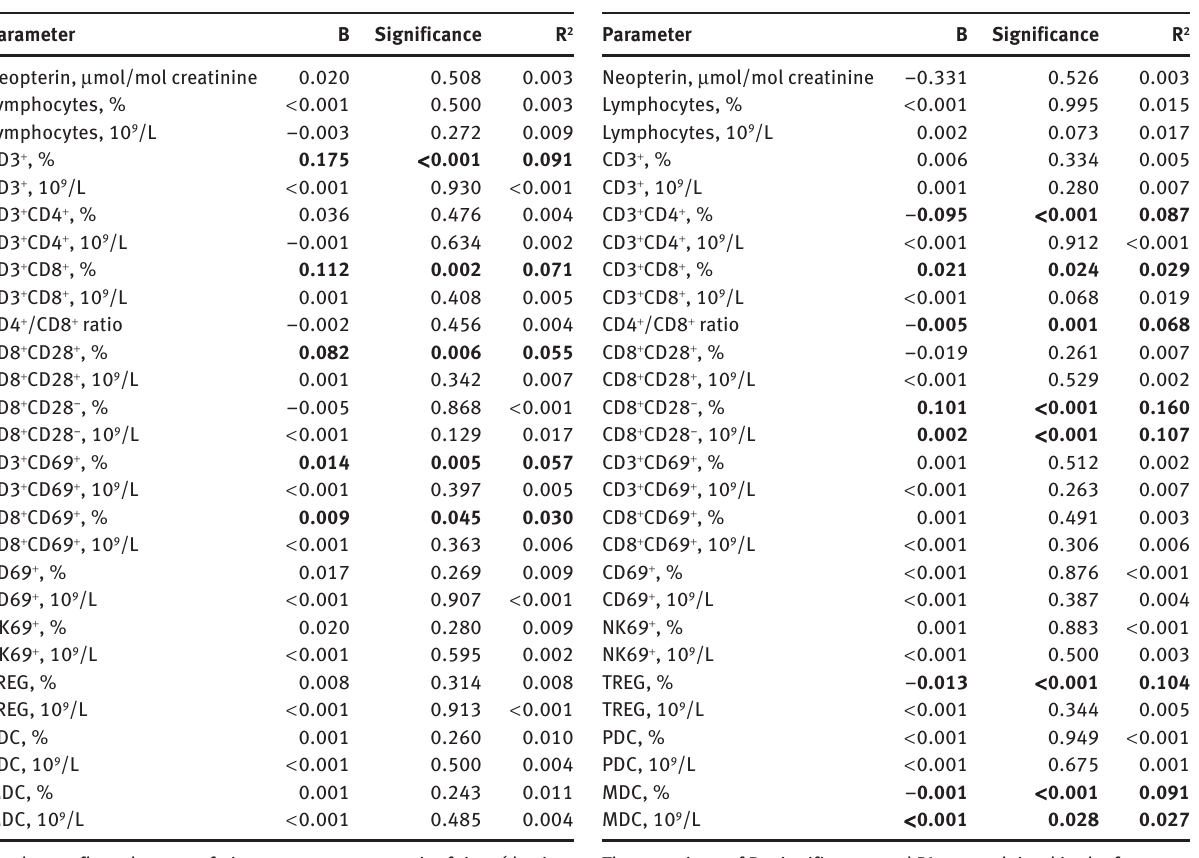
Table 3: Linear regression analysis of changes during the sequential weekly paclitaxel-based chemotherapy (cohort